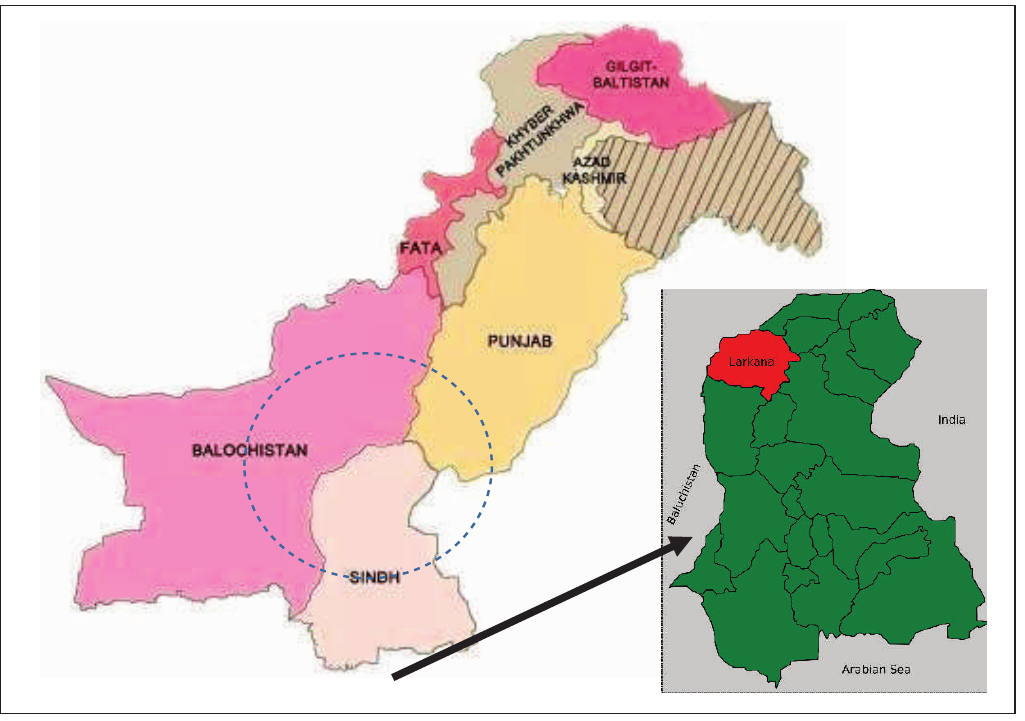
Figure 1: Map of Pakistan (pointer showing the study district and catchment area in the dotted circle)